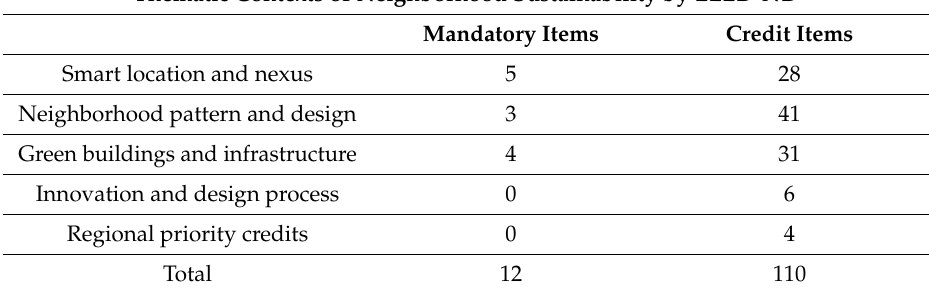
Table 3. Leadership in Energy and Environmental Design for Neighborhood Development (LEED-ND): thematic contexts.